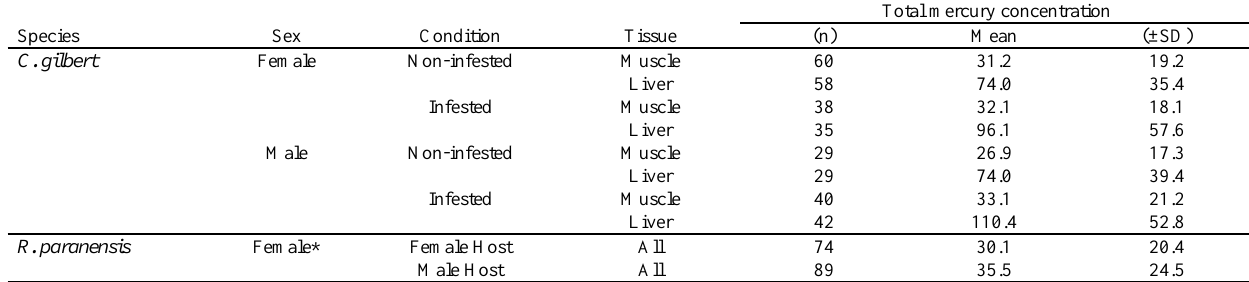
Table 4 . Total mercury concentrations (mean ± S.D. and range in ng.g -1 wet weight) in muscle and liver of non-infested and infested specimens of Cyphocharax gilbert and in the parasite Riggia paranensis obtained from female or male hosts, from the middle Itabapoana River, Brazil. (* )Only females were parasites (Bastos & Thatcher, 1997).